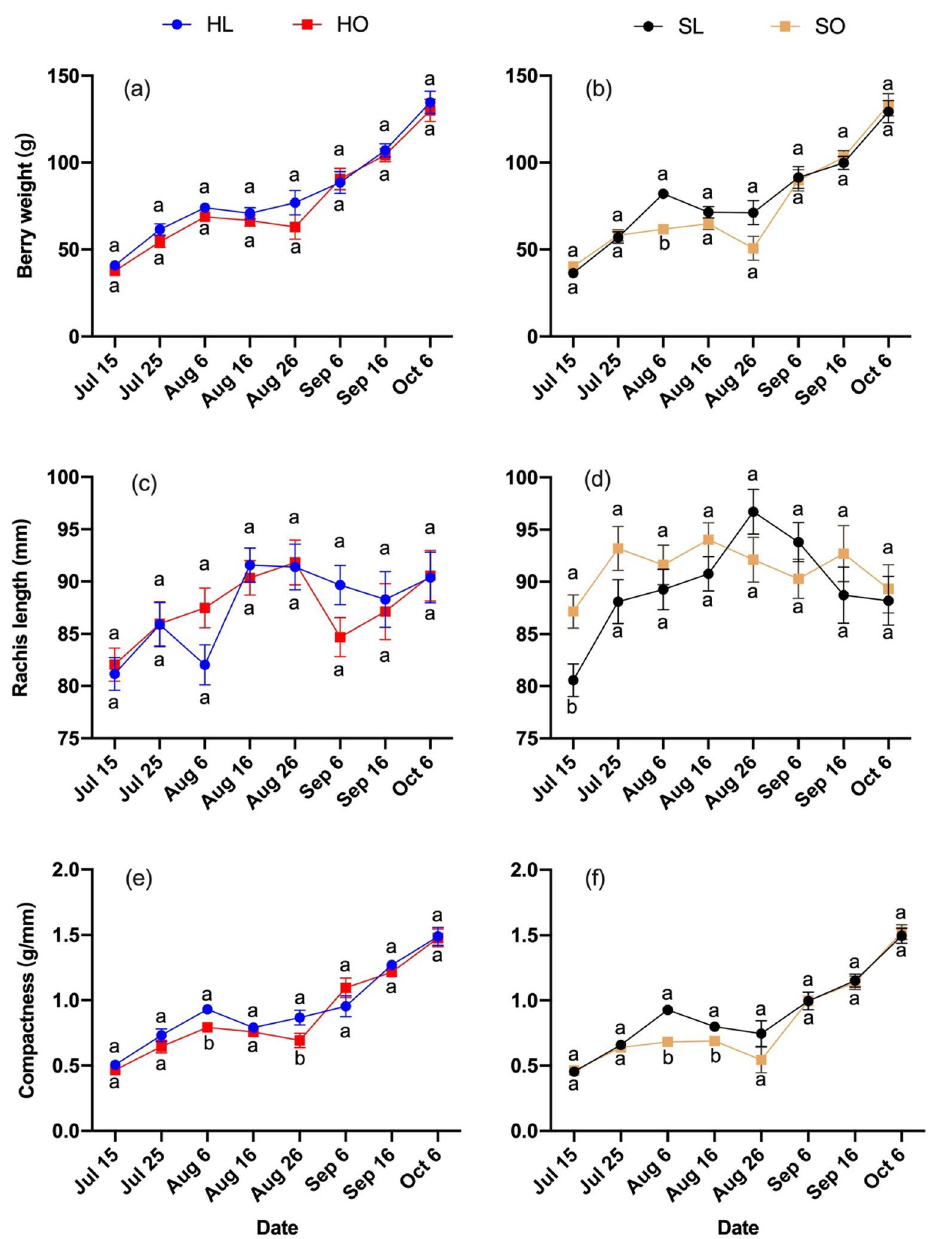
Figure 4. Berry compactness traits in response to different treatments during the growing season in 2019 of ‘Riesling’. Berry compactness traits: ( a , b ) Berry weight, ( c , d ) Rachis length, ( e , f ) Compactness. Treatments: (HL) Hedging with laterals, (HO) Hedging without laterals, (SL) Shoot wrap with laterals, (SO) Shoot wrap without laterals. Different lower-case letters showed significant differences at P ≤ 0.05